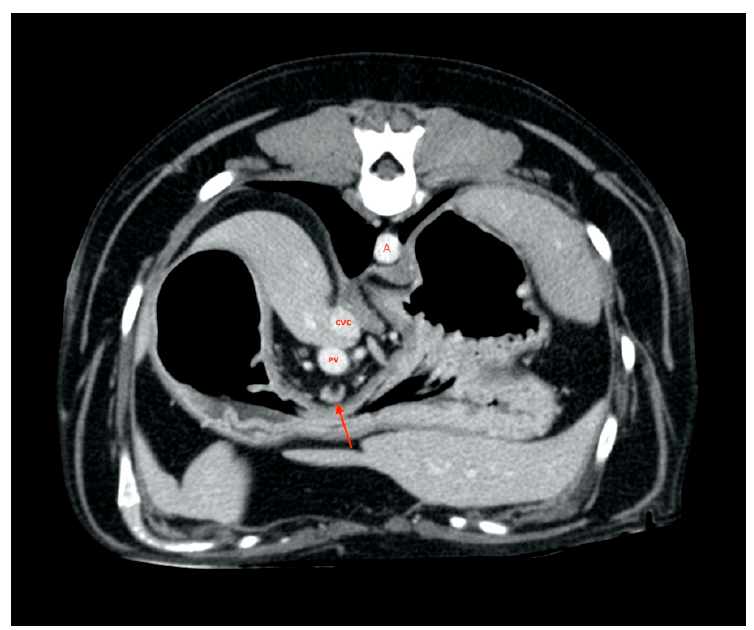
Figure 4. Gastric lymph node (red arrow). A, aorta. CVC, caudal vena cava. PV, portal vein A pancreaticoduodenal lymph node was always found in the right pancreatic lobe region (Figure 5).